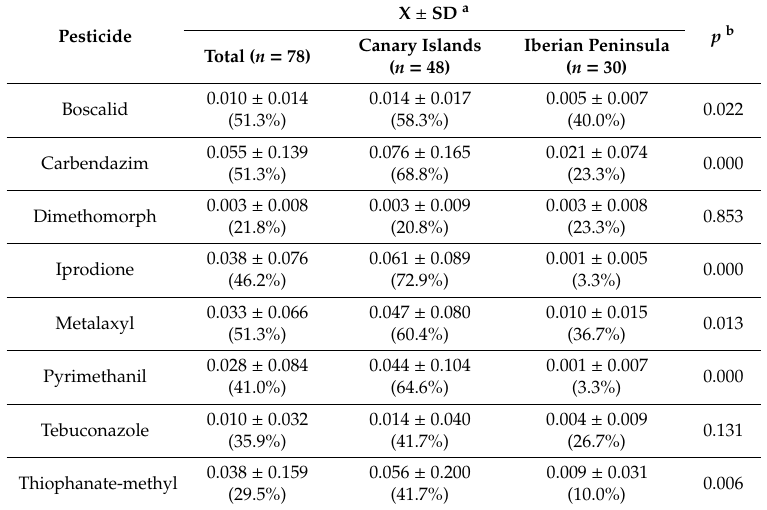
Table 2. Mean concentrations of the more abundant pesticides in the overall analysed red wine samples and their di ff erentiation according to their